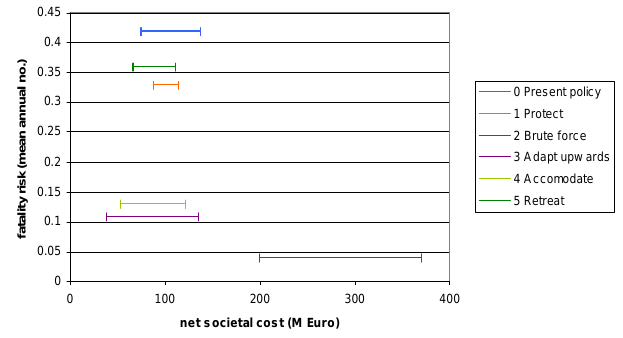
Fig. 7. Fatality risk as a function of net societal cost of each strate- Figure 7. Fatality risk as function of net societal cost of each strategic alternative, with an 2 gic alternative, with an indication of uncertainty about the precise indication of uncertainty about the precise annual societal costs (= implementation + 3 annual societal costs ( = implementation + maintenance + remaining economic risk) indicated by the “range” over the horizontal maintenance + remaining economic risk) indicated by the ‘range’ over the horizontal axis. 4